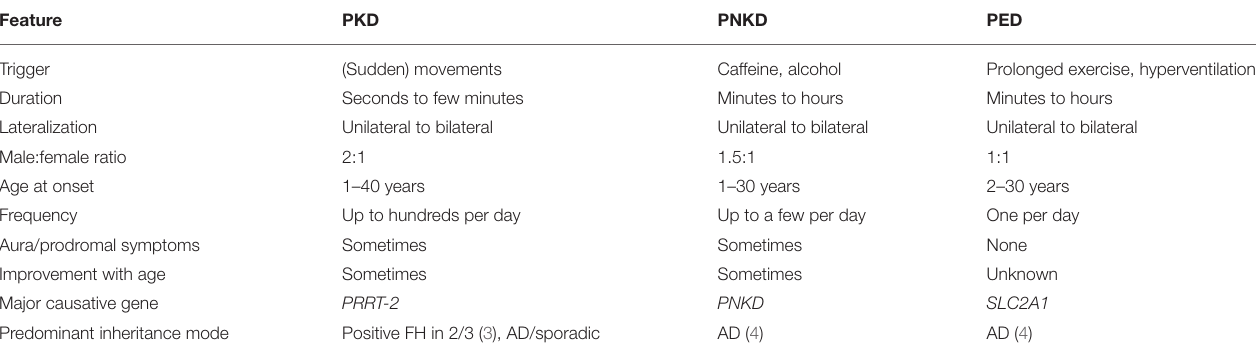
TABLE 1 | Phenotypic characteristics of paroxysmal